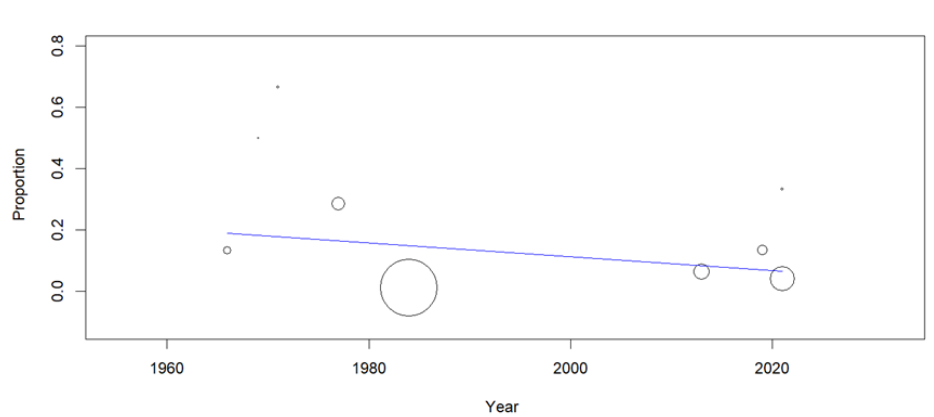
Figure A1. Bubble plot of meta-regression on the chronic hyperplastic candidiasis malignant trans- formation rate plotted against the year of study.